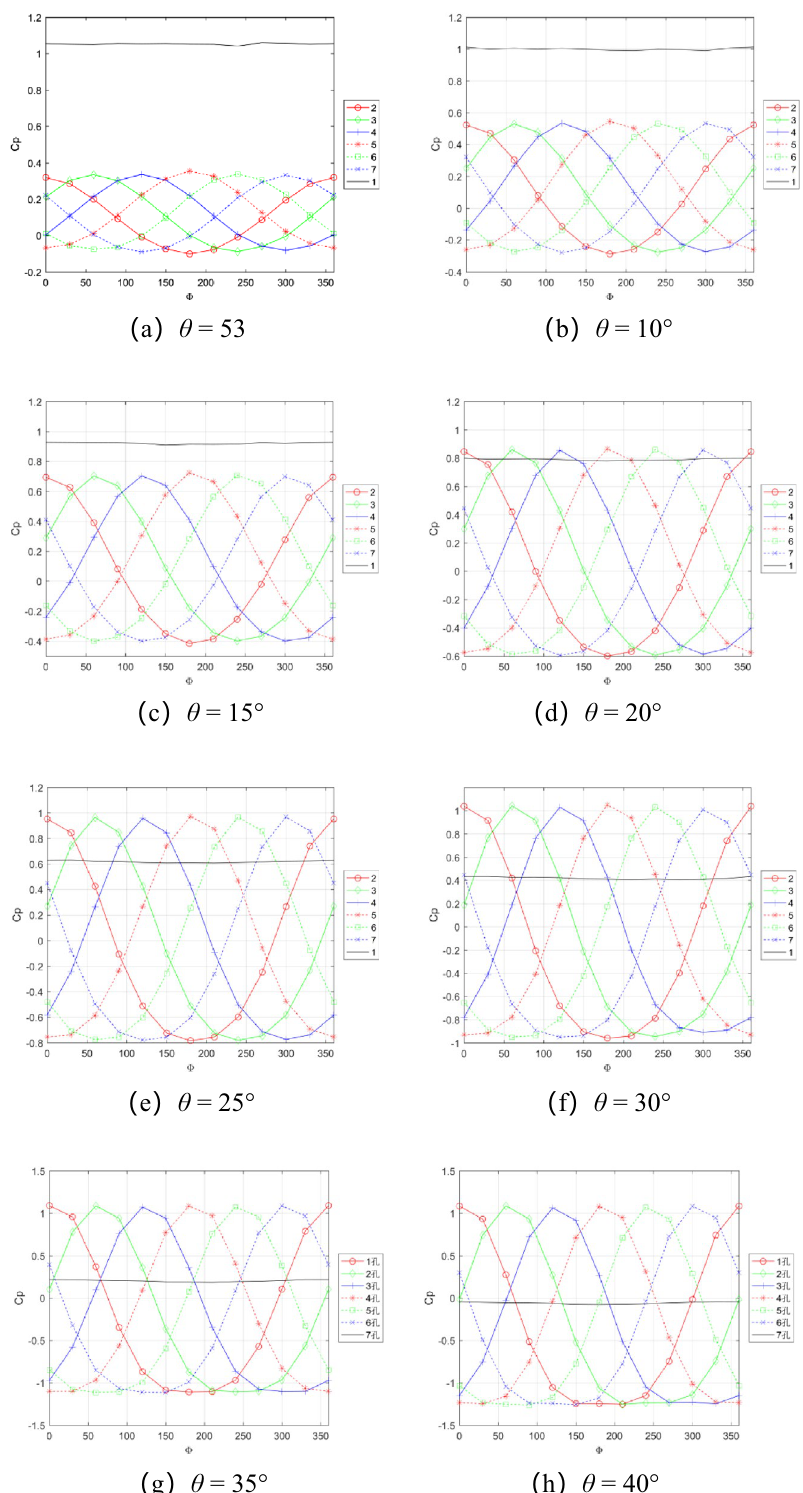
Figure 8. Variation curve of pressure coefficient of seven holes with roll angle at different pitch